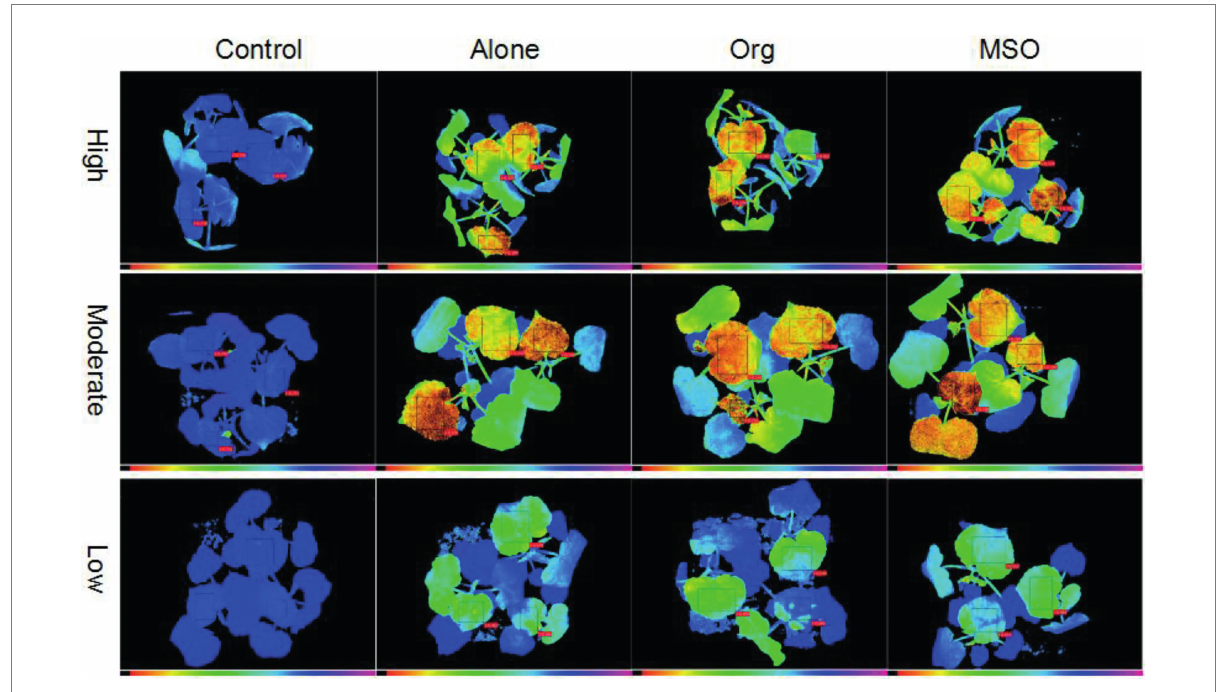
FIGURE 2 Chlorophyll fluorescence images of velvetleaf at 3 days after treatment. The topramezone dose was 6.3 g a.i. ha − 1 ; control means treated with tap water; Alone means topramezone was applied alone; Org means topramezone was applied together with a tank-mix of organosilicone; MSO means topramezone was applied together with a tank-mix of MSO.